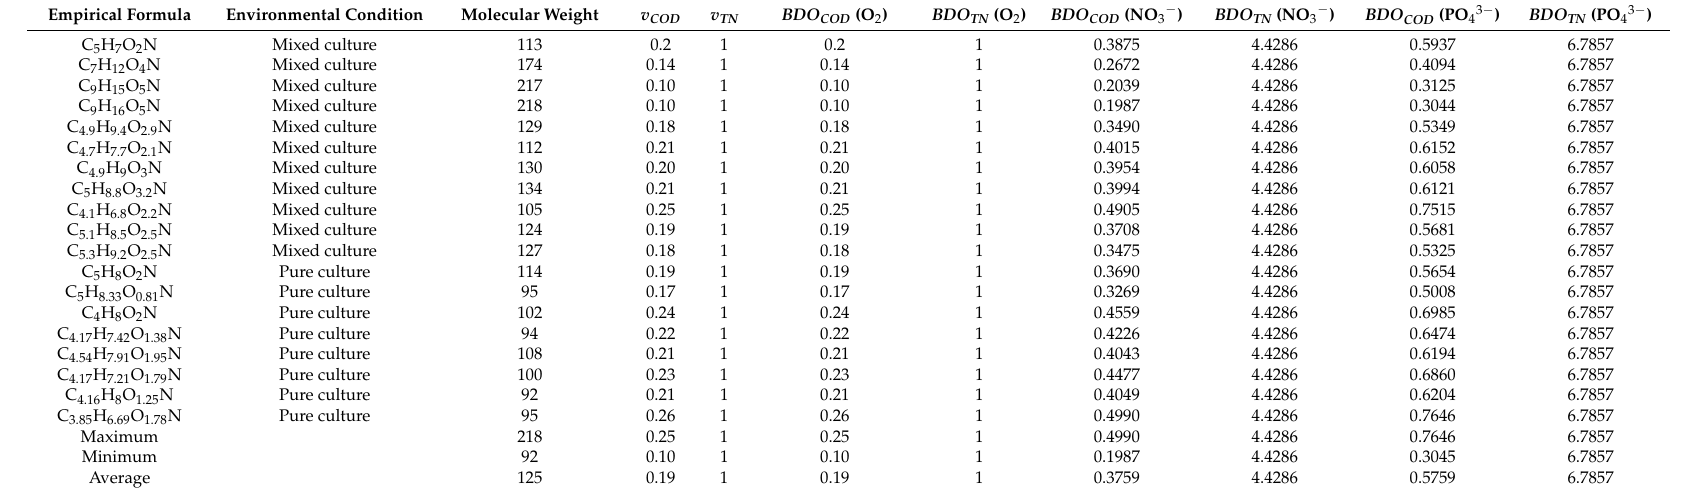
Table 1. Characterization factors for COD and TN with respect to the impact category of BDO based on different environmental conditions and reference substances (O 2 , NO 3 − , and PO 43 −